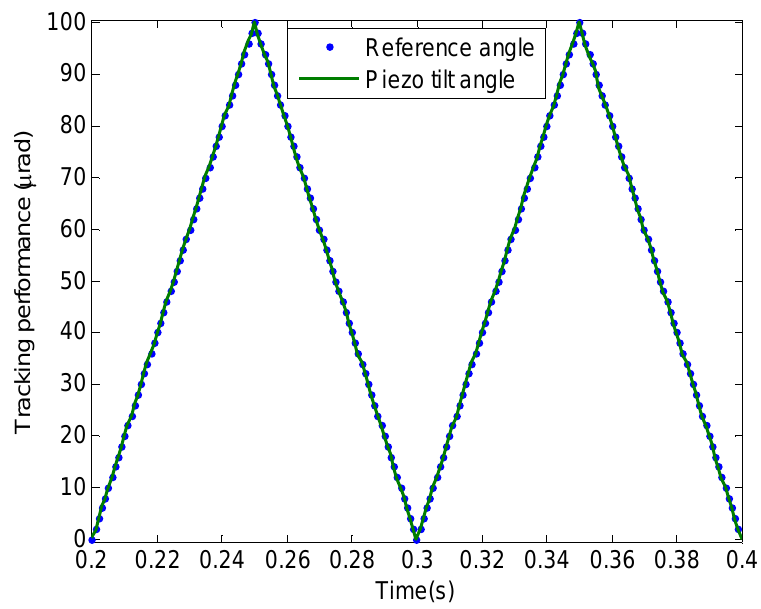
Figure 13. Tracking performance of the triangle